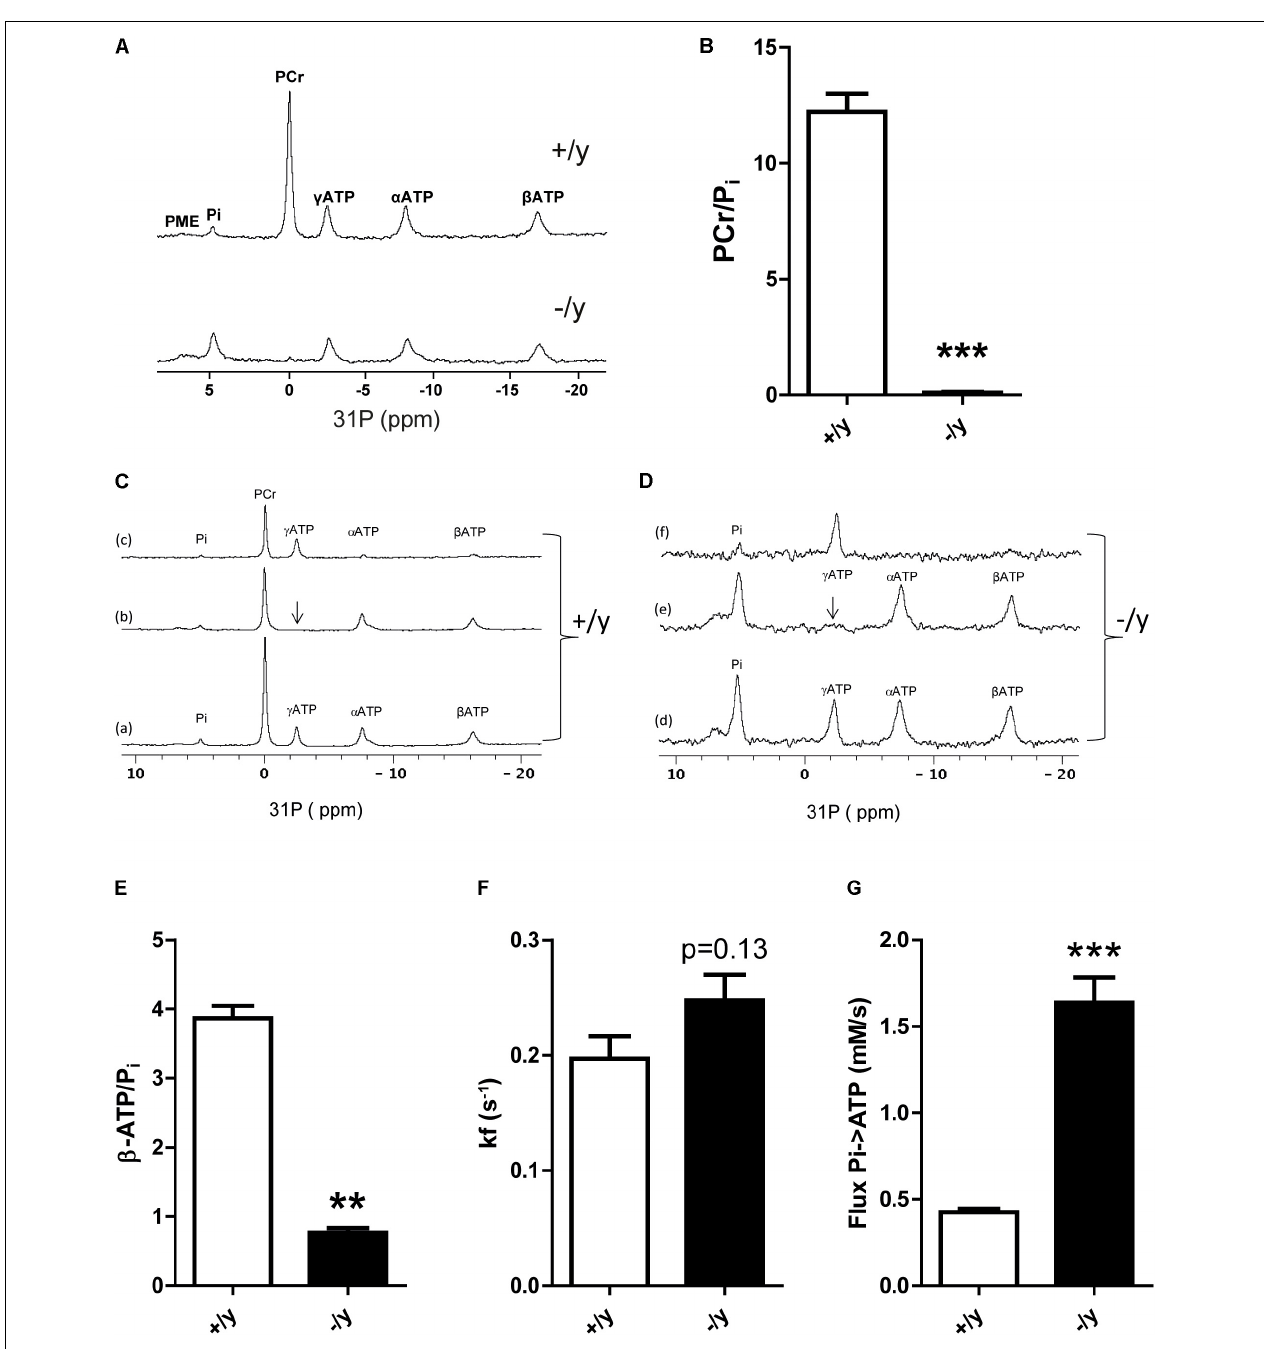
FIGURE 7 | Muscle energy metabolism. (A) Representative 31 P MR spectra of hind limb muscle in CT1 + / y and CT1 − / y mice (PCr, phosphocreatine; Pi, inorganic phosphate; PMEs, phosphomonoesters; ppm, parts per million). (B) PCr/P i ratios in CT1 + / y and CT1 − / y mice measured with 31 P MR spectroscopy ( n = 4–5). (C,D) Saturation transfer 31 P MRS experiments on hind limb muscle of CT1 + / y (A) and CT1 − / y mice (B) to assess the Pi → ATP kinetics. The γ ATP peak is saturated